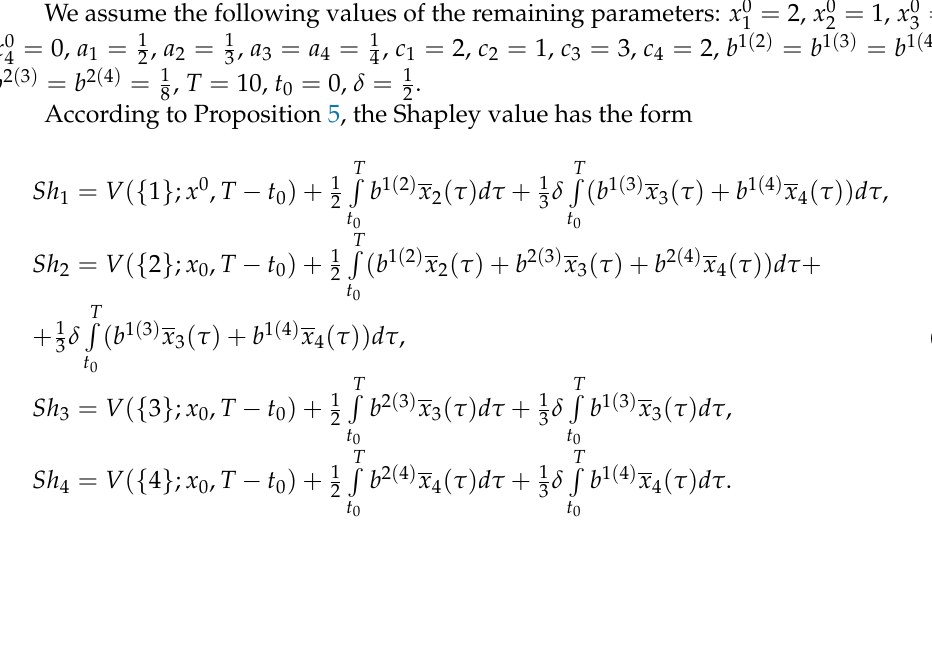
Figure 1. A four-player multi-level marketing